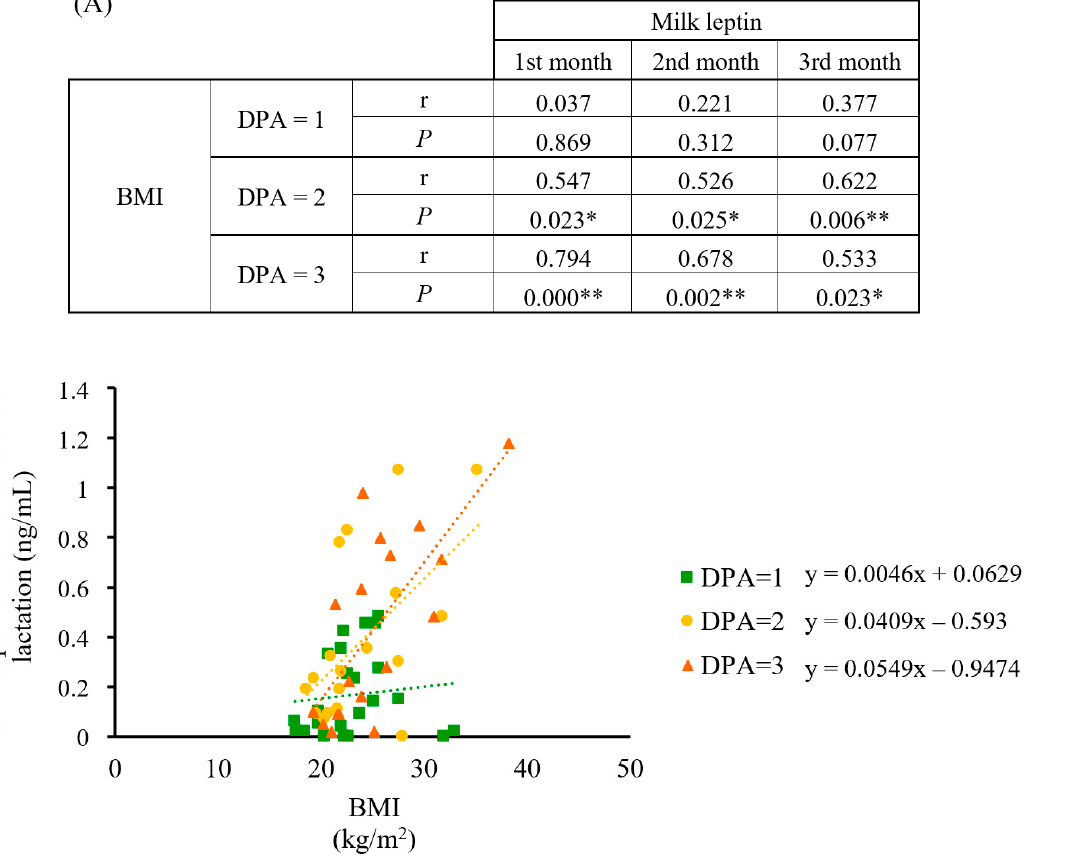
Figure 7. Correlation analysis between BMI and breast milk leptin concentration in the cohort clas- sified by DPA score ( n = 23, 18, and 18, respectively). ( A ) Spearman’s correlation data between BMI and leptin at the first, second, and third month of lactation by DPA score; ( B ) scatter plot and linear regression trend lines with data from the second month of lactation. Statistics: Spearman’s correla- tion test, * p -value ≤ 0.05 (** = p -value < 0.01). Abbreviations: BMI: body mass index; DPA: diet pro-